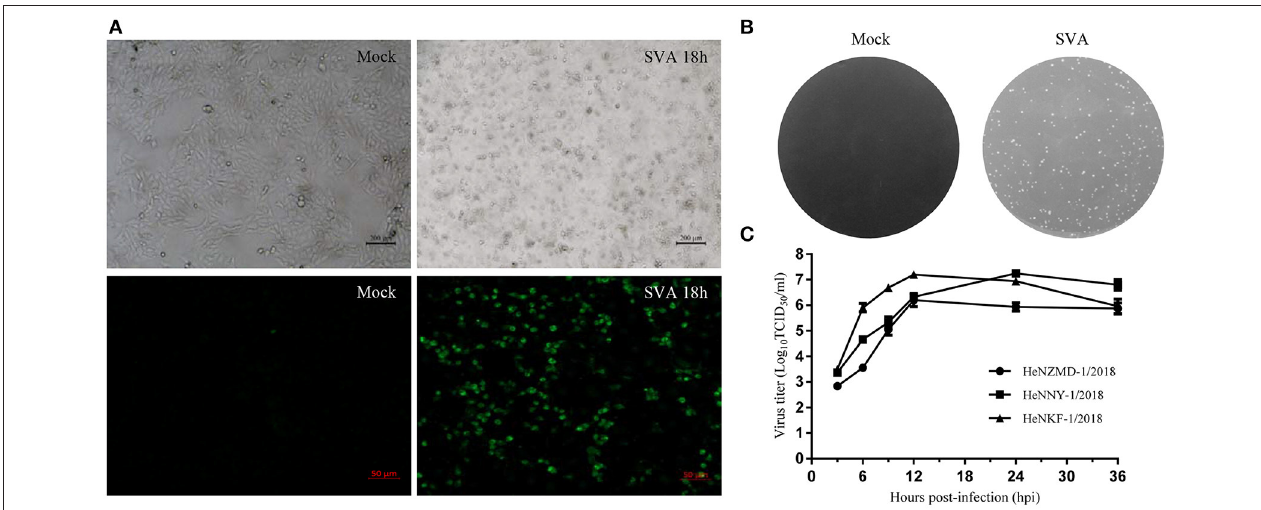
FIGURE 1 | Isolation of SVA strains. (A) Representative images of cytopathic effects and immunofluorescence assay. PK-15 cells infected with SVA HeNNY-1/2018 strain at 18h post-infection. Cells were stained with primary antibody of porcine SVA positive serum. (B) Representative plaque morphology in PK-15 cells infected by HeNNY-1/2018 strain at 72h post-infection. (C) One-step growth curve of three SVA isolates on PK-15 cells.